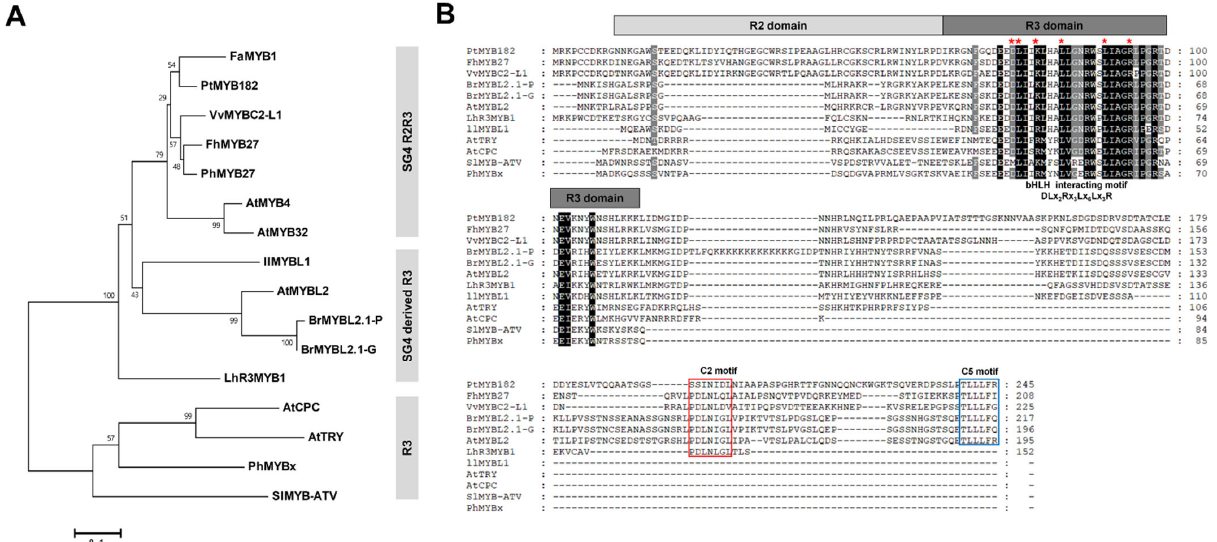
Figure 3. Phylogenetic relationships and multiple sequence alignment among anthocyanin MYB repressors from Chinese cabbage and other plant species. ( A ) Phylogenetic tree of BrMYBL2.1 and other MYB repressors proteins from other plants. The phylogenetic tree was constructed using the neighbor-joining method with MEGA6 software. Numbers next to the nodes are bootstrap values from 1000 replications. The scale bar corresponds to 0.1 amino acid substitutions per site.